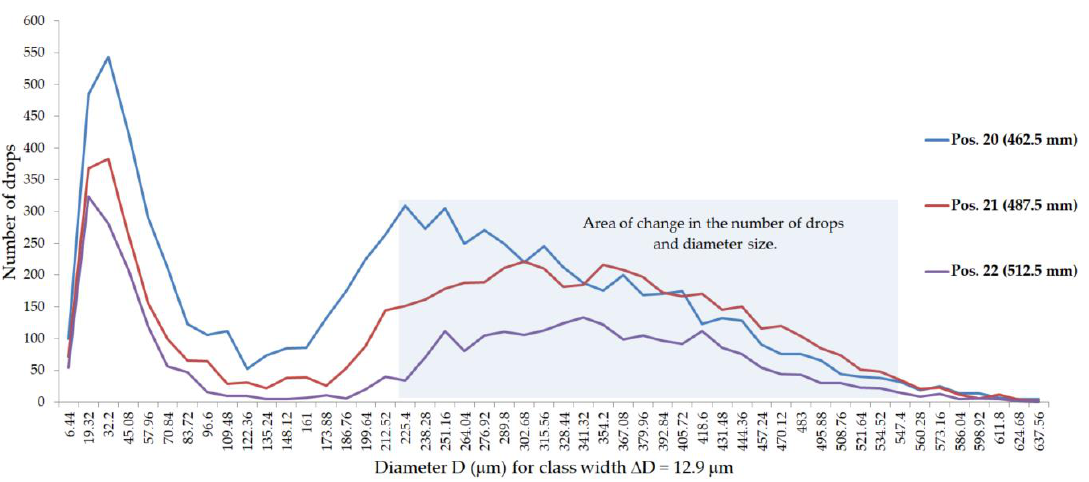
Figure 8. The number of occurrences of drops in the diameter class for nozzle number 2, right side of the stream, measuring positions 18 to 22.